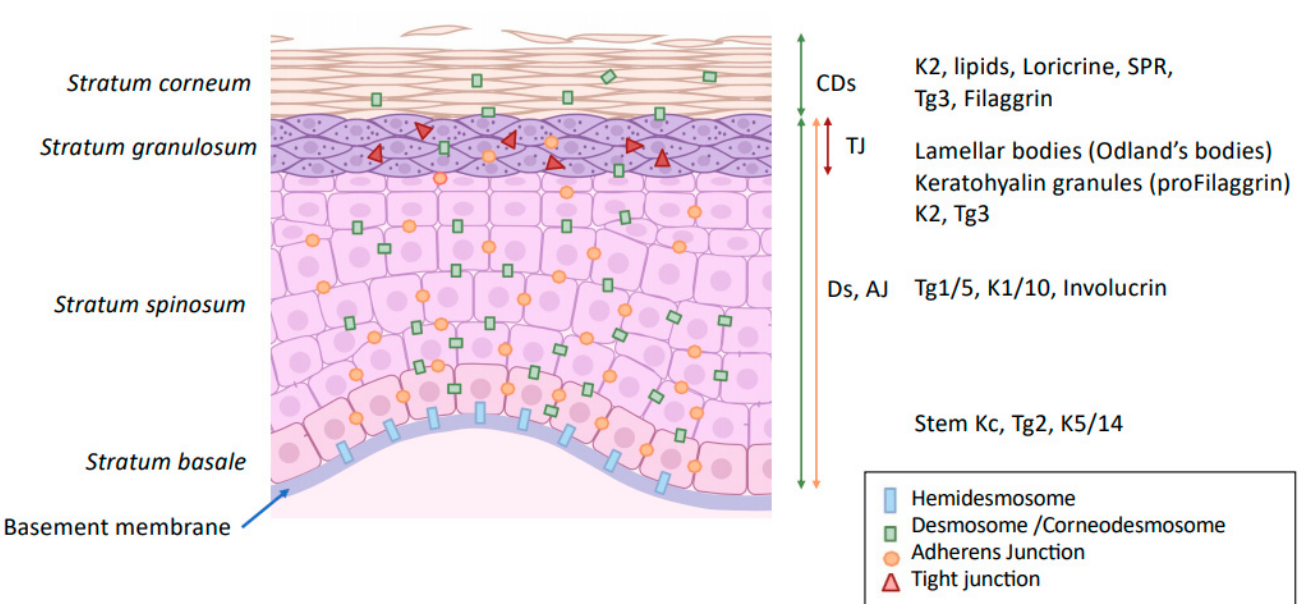
Figure 1. Modification of intercellular junction along keratinocyte differentiation. Kc: keratinocytes Ds: desmosome; CDs: corneodesmosome; TJ: tight junction; AJ: adherens junction; K: keratin; Tg: transglutaminase; SPR: small proline-rich pro- teins.